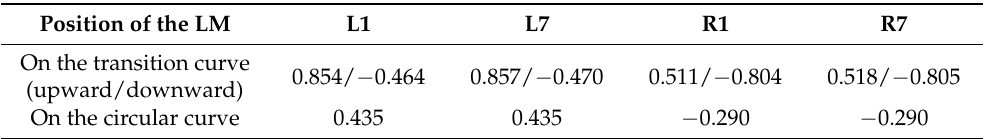
Table 3. Maximum Deflection deformation amplitudes of the LMs on the 650 m radius curve (unit: mm, V = 130 km/h).